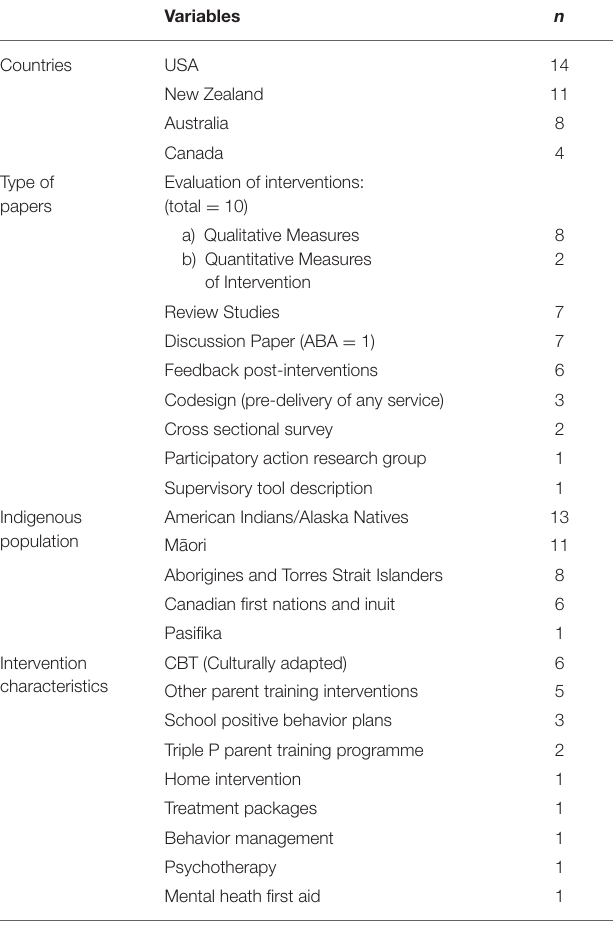
TABLE 1 | Characteristics of the